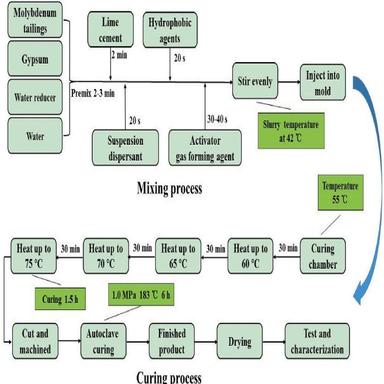
Flow chart for mixing and curing process of specimens.